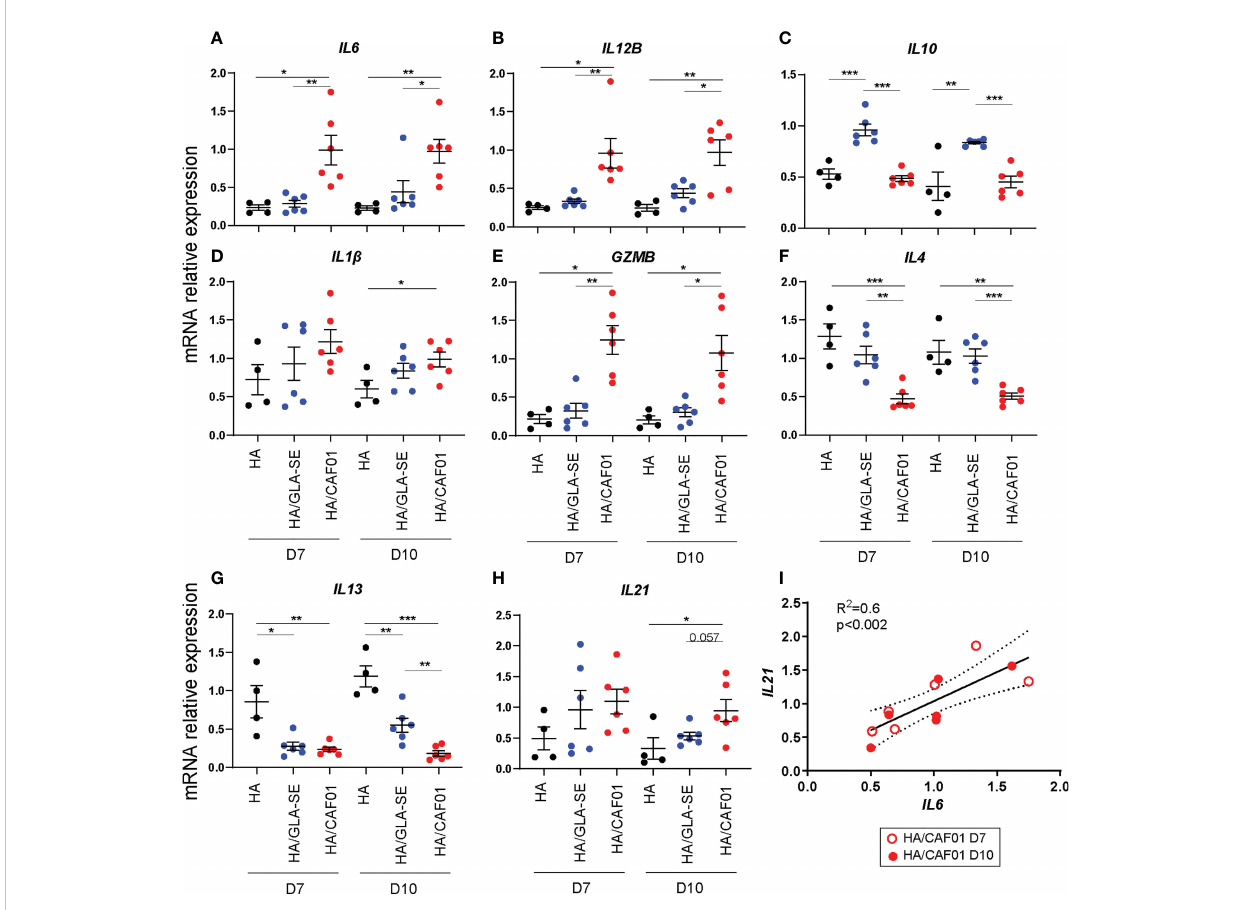
FIGURE 4 CAF01-elicited neonatal adaptive responses develop in an IL6-rich environment. (A-H) . One week-old CB6F1 mice were immunized s.c. with HA/ PBS, HA/CAF01 or HA/GLA-SE and the two draining LNs were collected at day 7 or 10 post-immunization. RNA from total dLNs was used to measure the expression levels of selected genes by RT-PCR. mRNA expression levels of (A) IL6 , (B) IL12B , (C) IL10 , (D) IL1B , (E) GZMB , (F) IL4 and (G) IL13 , and (H) IL21 are shown. Dots show values per individual mouse (N ≥ 4 per group) whereas black bars indicate means ± SEM. Statistical analysis were performed using the Mann-Whitney U test: * P <0.05, ** P <0.01, *** P <0.001. (I) Graph showing the correlation between the mRNA expression levels of IL6 and IL21 in dLN of neonates receiving HA/CAF01; data from day 7 (open circle) and 10 ( fi lled circle) post-immunization were pooled. N = 6 mice/group; Data were pooled from two independent experiments per time